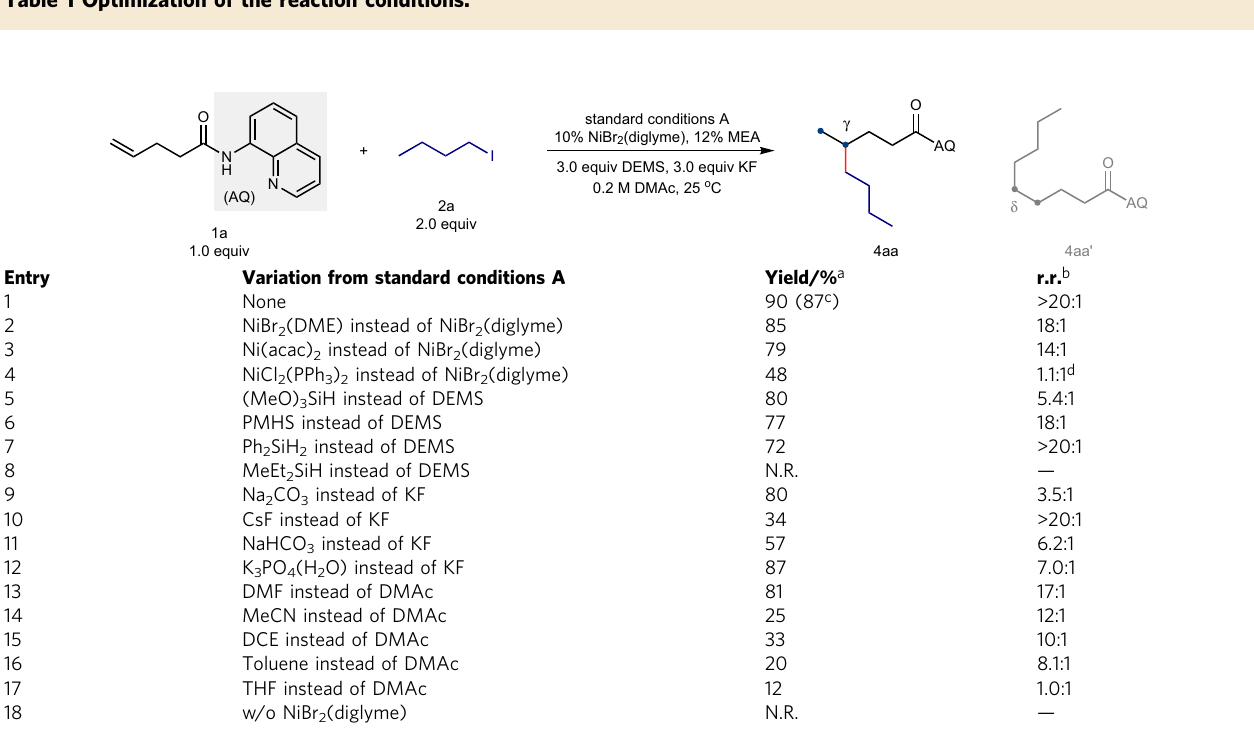
Table 1 Optimization of the reaction